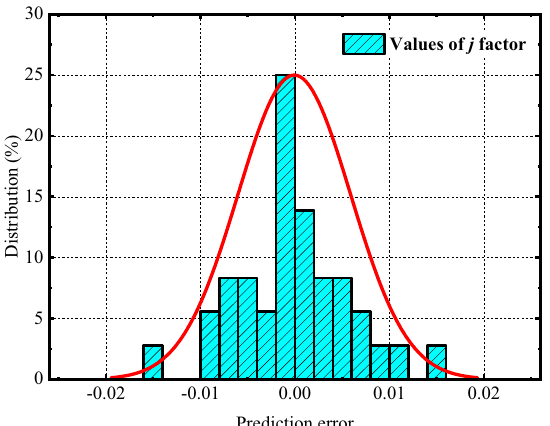
Figure 11 Absolute error distributions of JF factor prediction